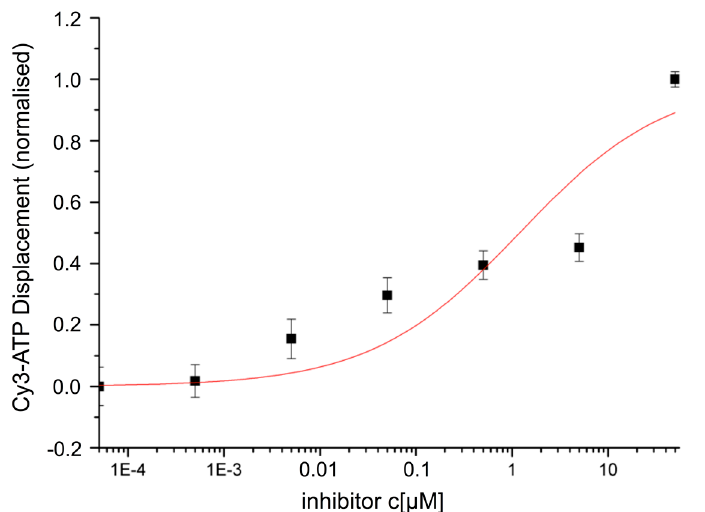
Figure 2c. Competitive assay of Cy3-ATP by geldanamycin derivative 18-dehydrox-19- fluoro-reblastatin [13] on cancer cell lysates. Concentrated human cancer cell lysate obtained from cell culture was printed on microarray surface and bound Cy3-ATP was competed by a geldanamycin derivative. The IC value was obtained from dose-response curve 50